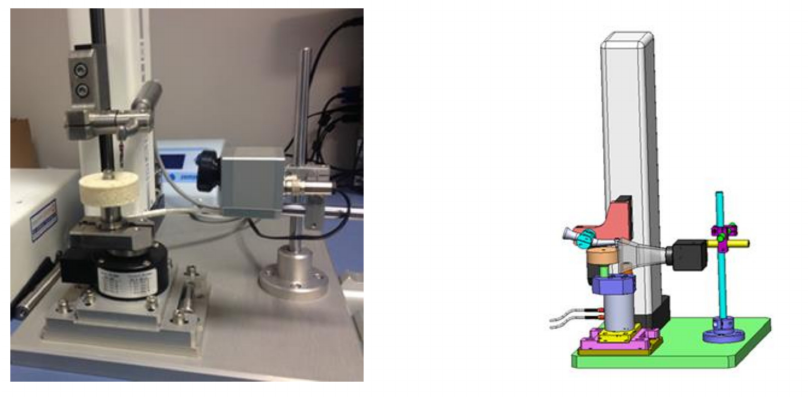
Figure 4. Testing measurement system.